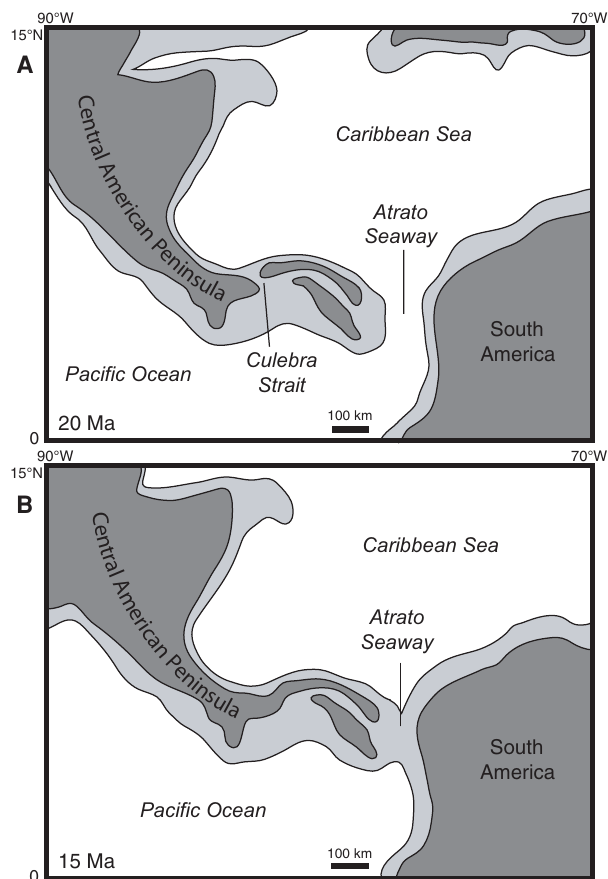
Figure 11. Paleogeographic reconstructions of Central America for (A) 20 Ma and (B) 15 Ma. Light gray represents the outline of tectonic plates containing continental or volcanic-arc crust. Dark gray represents subaerial land. Base maps for the reconstructions were derived from the ODSN Plate Tectonic Reconstruction Service (http:// www.odsn.de/odsn/services/paleomap/paleomap.html). The location of subaerial land is based on this study and the distribution of Cretaceous to Tertiary continental and volcanic terranes as derived from Case and Holcombe [70].